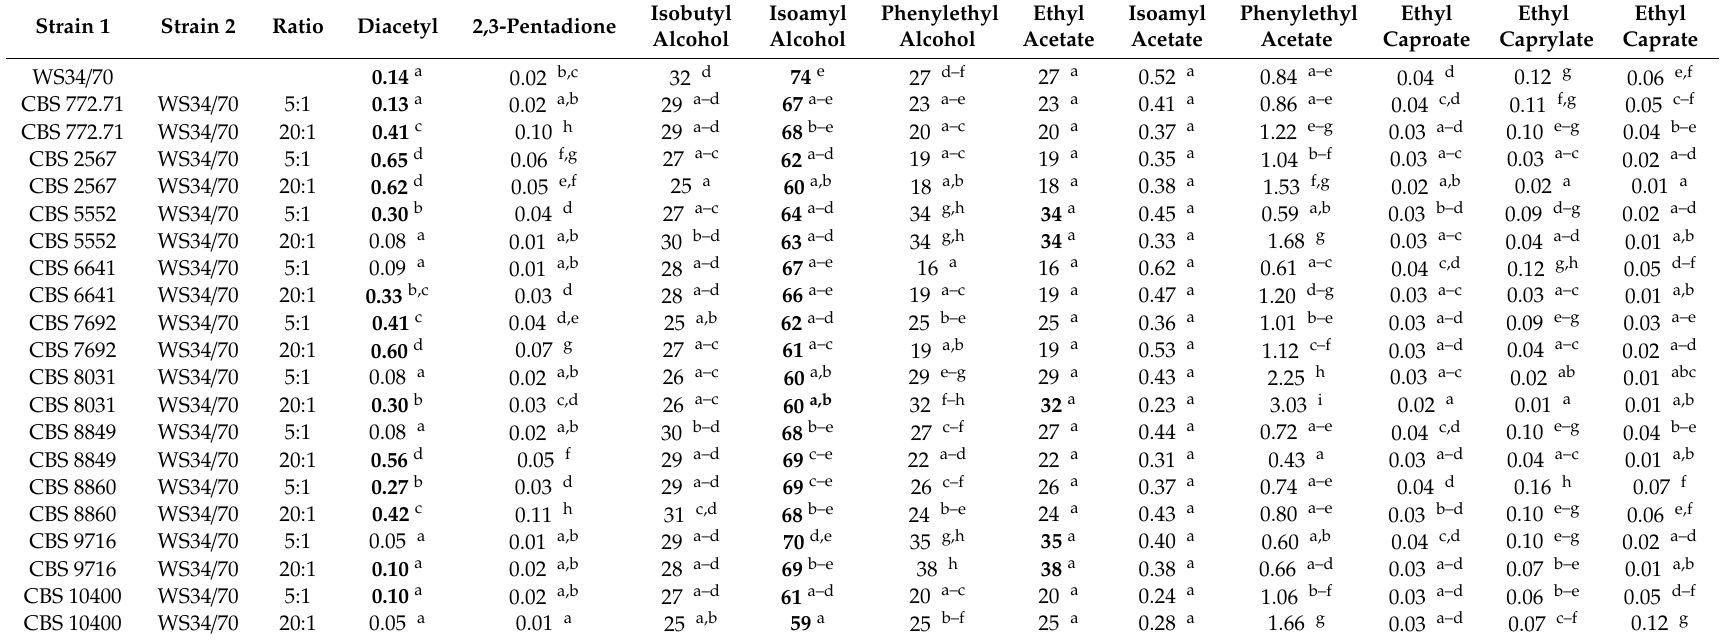
Table 6. Aroma compounds (mg / L) in the resulting